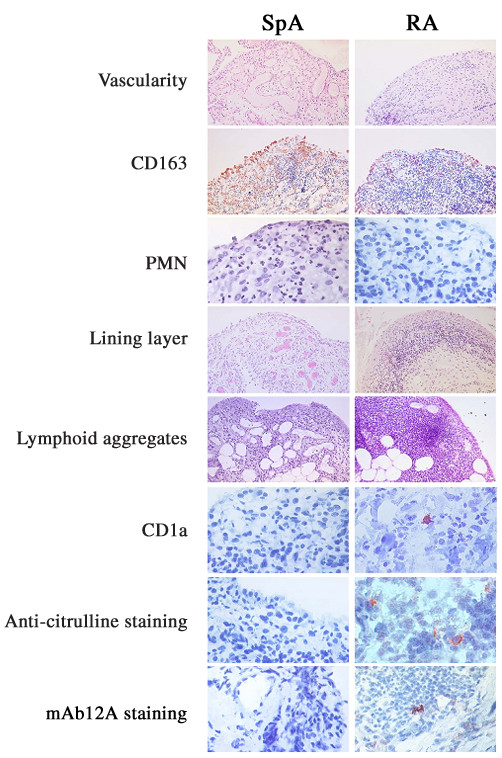
Distinct synovial features in spondyloarthropathy (SpA) and rheumatoid arthritis (RA). Vascularity, CD163+ macrophages, and polymorphonuclear leukocytes (PMNs) were significantly increased in SpA, whereas lining-layer hyperplasia, lymphoid aggregates, CD1a+ dendritic cells, intracellular citrullinated proteins (detected by anticitrulline staining), and MHC–HC gp39 complexes (detected by staining with monoclonal antibody (mAb) 12A) were higher in RA.